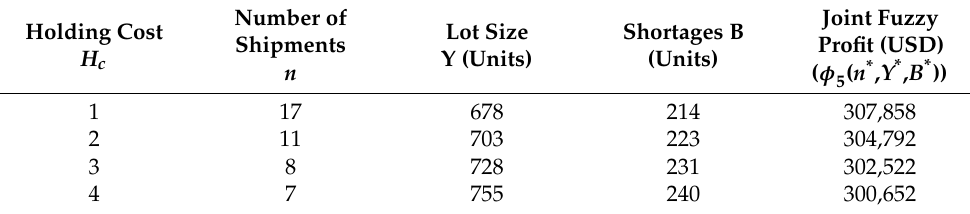
Table 8. Impact of the vendor’s holding cost on the decision variable and joint fuzzy profit.